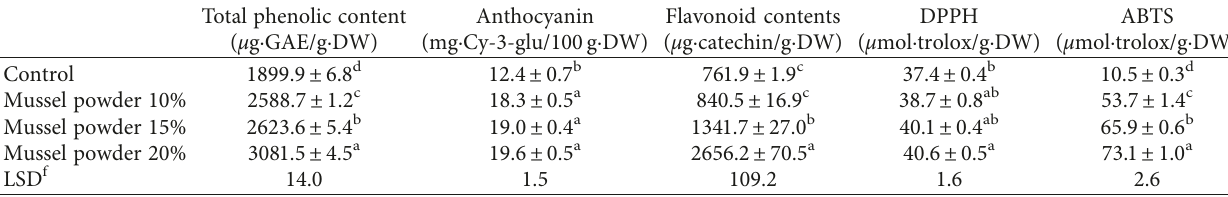
Table 4: Bioactive compound contents of fortified biscuits with mussel powder and spices e